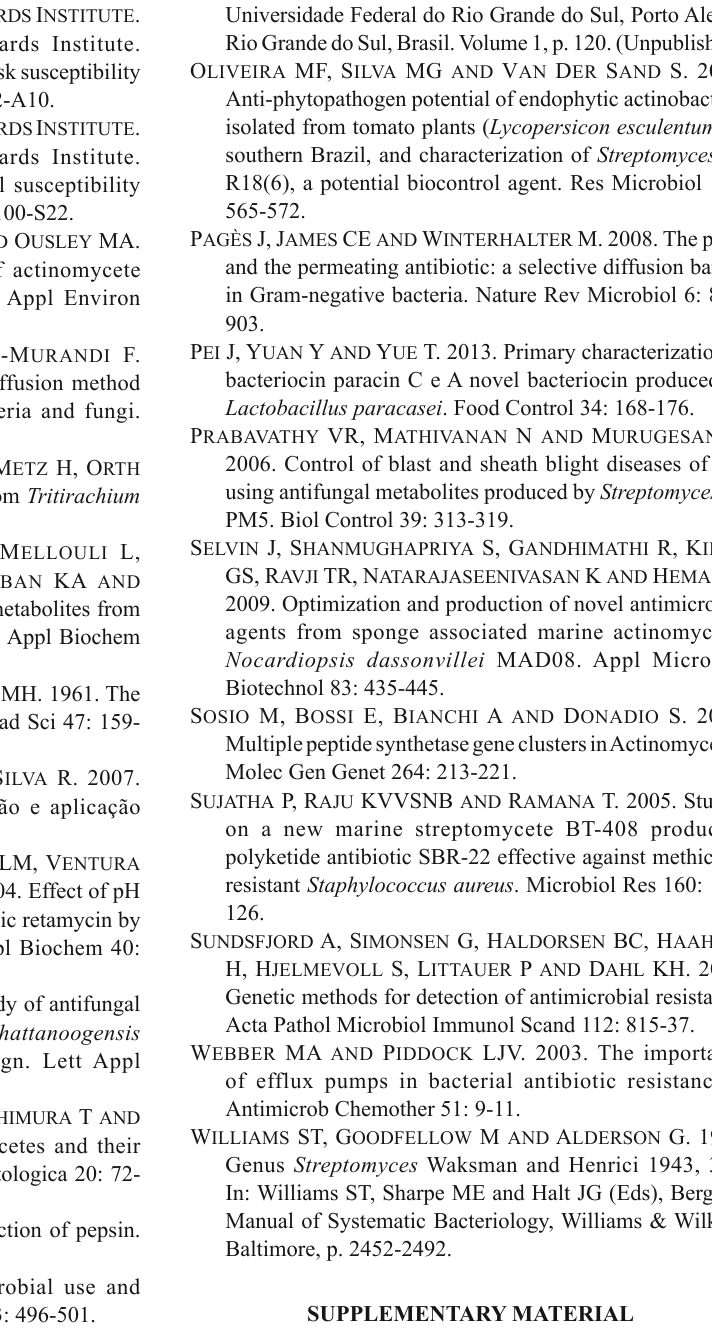
TABLE SI - Susceptibility pro fi les of Gram-negative bacteria isolated from environmental and clinical samples challenged with the antimicrobials chosen for the assay. Dishes were incubated at 35 ºC for 24